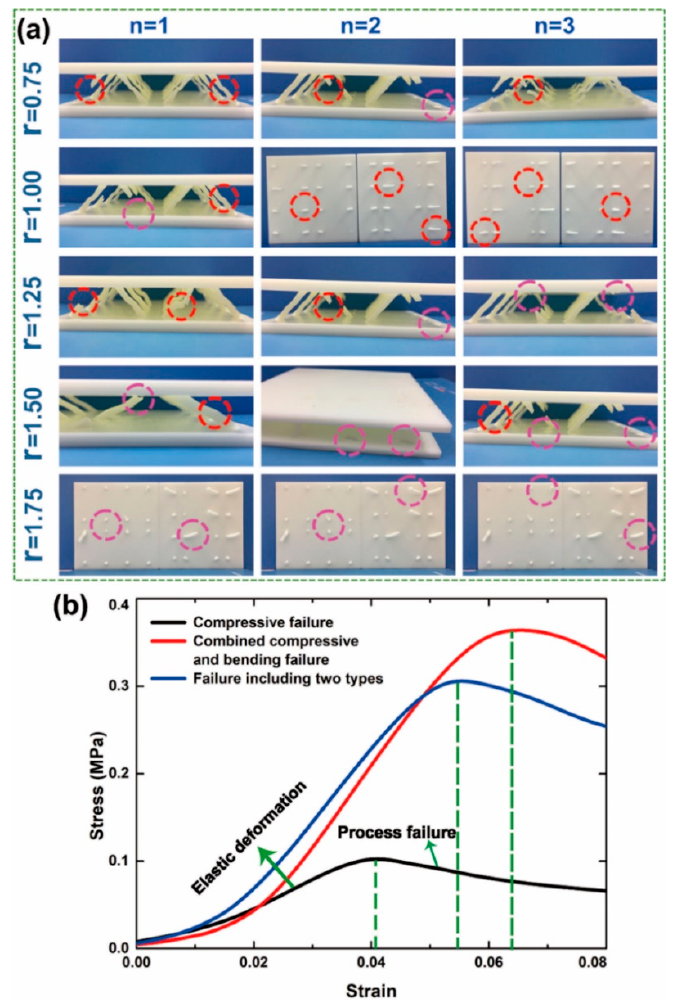
Figure 7. ( a ) 2-D lattice structures with the variable cross-section core failure types and ( b ) compressive stress–strain curves for the 3 failure types.